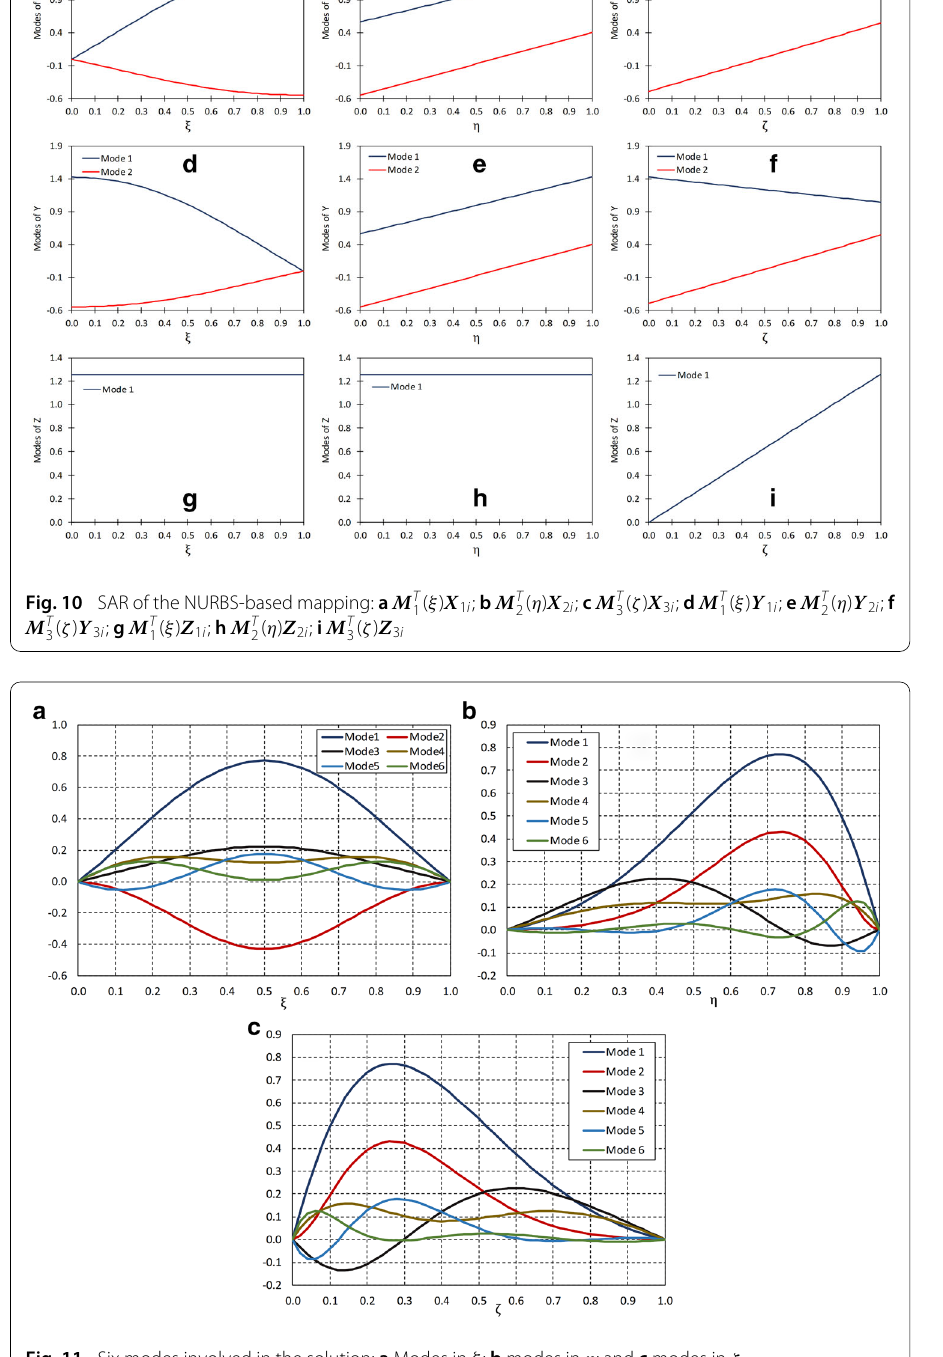
Fig. 11 Six modes involved in the solution: a Modes in ξ ; b modes in η ; and c modes in